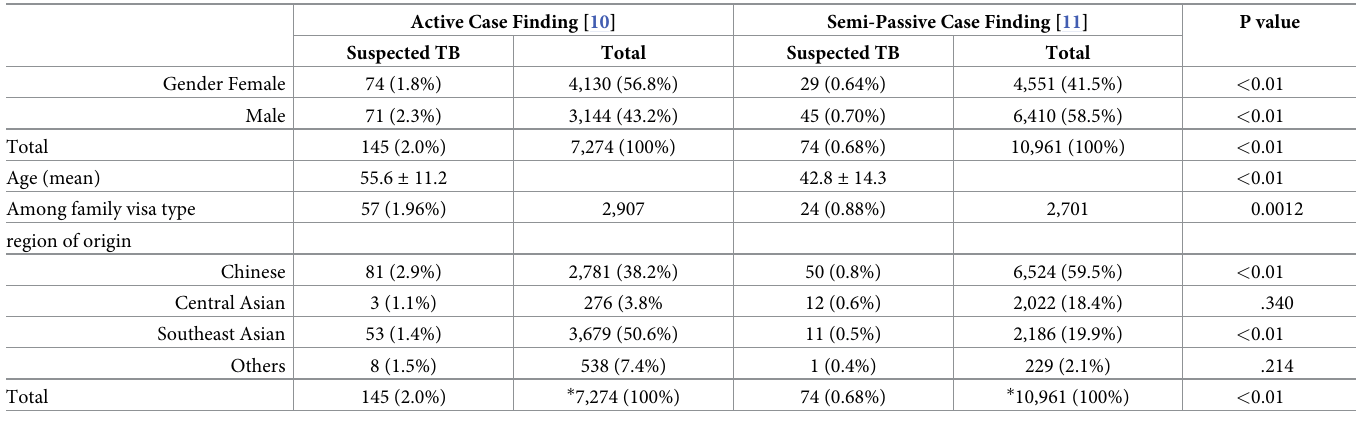
ACF has shown a higher suspected TB rate in older adults, while semi-PCF tended to show a higher suspected TB rate in younger adults (Table 2). For individuals older than 60 years, the suspected TB rate on CXR was significantly higher in ACF (36.6%) than in semi-PCF (12.2%) (P < 0.01).